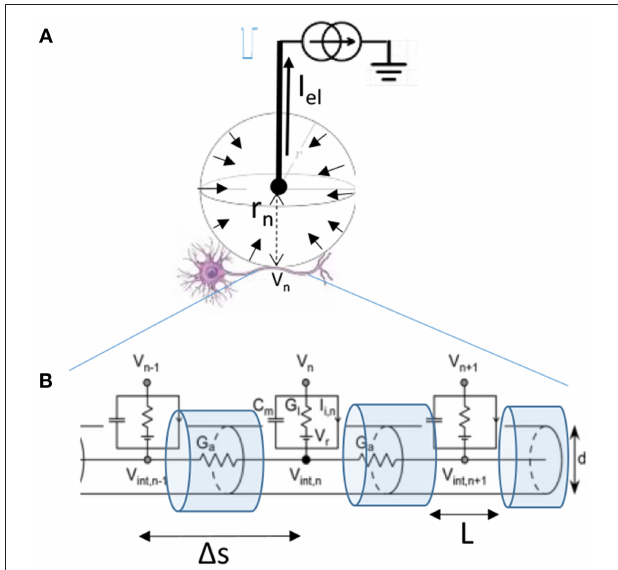
FIGURE 3 | (A) Diagram of the single monopolar electrode distance r n from the center of the targeted neuron. Because current travels to the electrode from all directions, we can assume that I el is distributed over a sphere indicated by short arrows in an isotropic medium. (B) Myelinated axon of diameter d of the targeted neuron is modeled by compartments length 1 s between nodes of Ranvier, with L representing the length of exposed membrane. Figure adapted with permission from Joucla and Yvert (2012).